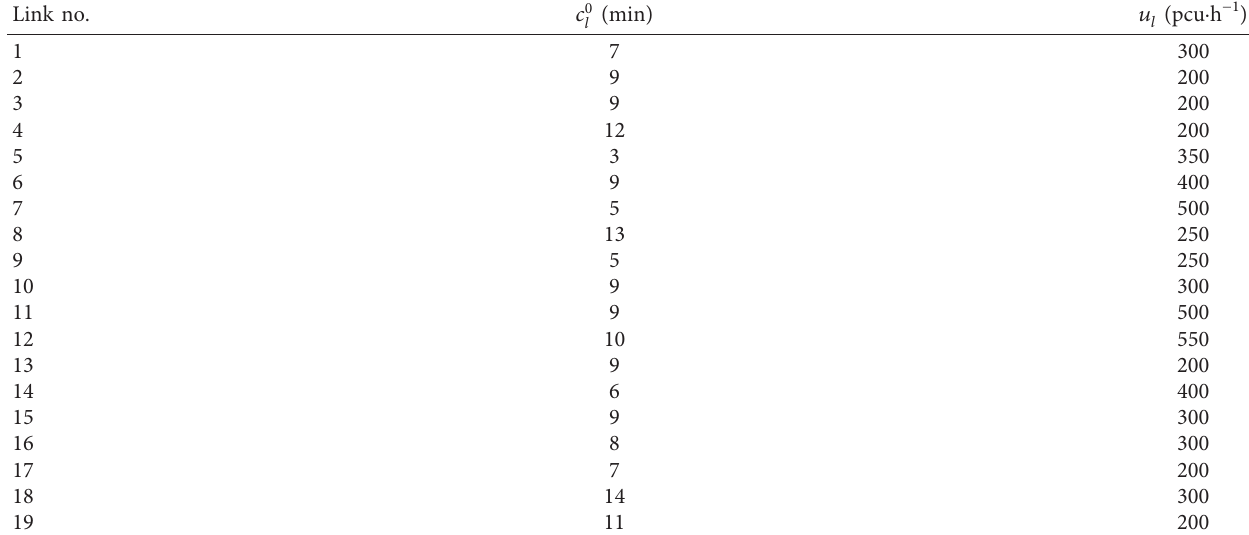
Table 4: Network